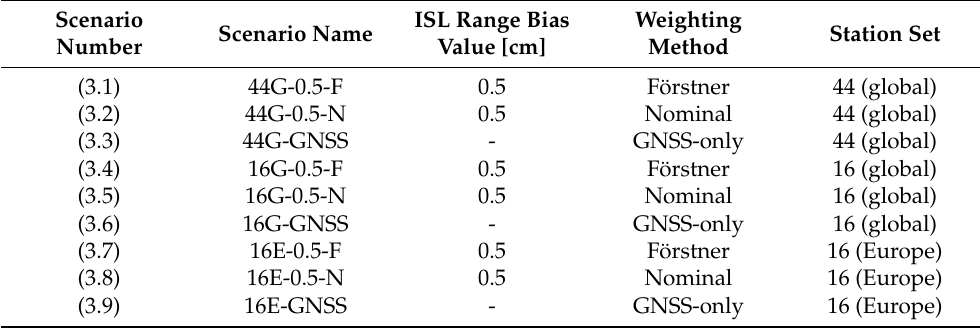
Table 7. Summary of simulation scenarios used analysis of number of ground station on clock estimation and signal-in-space range error